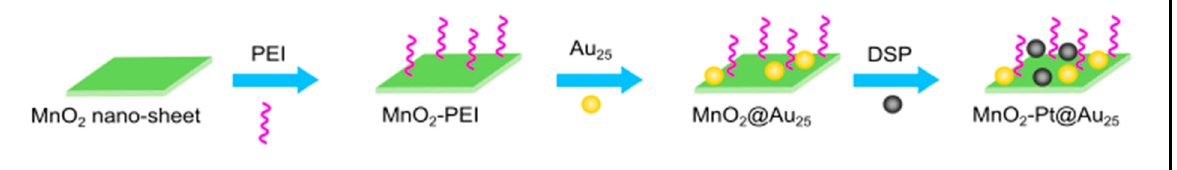
Figure 3. MnO 2 -Pt@Au 25 nano-platform: a system that can be considered as both drugs and photo- sensitizer. Polyethylene imine: PEI (figure created with Inkscape).